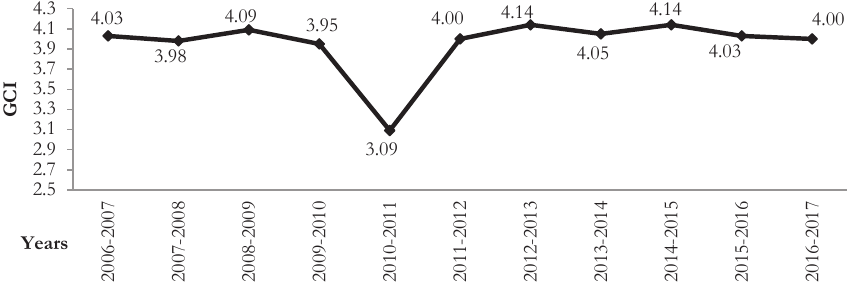
Fig. 1 – Global Competitiveness Index (GCI) for Ukrainian Economy in 2006-2017. Source: http://www3.